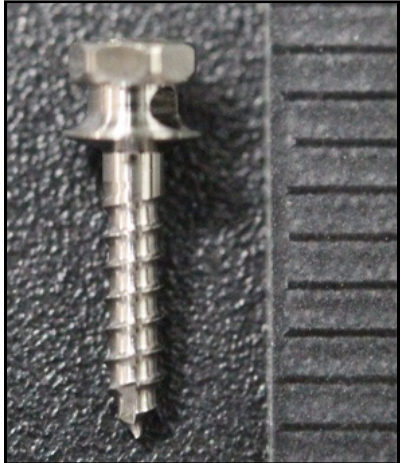
Figure 1. An image of Ti6Al4V miniscrew. Thirty miniscrews (Jeil Medical Corporation, Seoul, South Korea) that were 1.3 mm in diameter and 6 mm in length were used in miniscrew insertion tests. 1 scale = 1 mm.